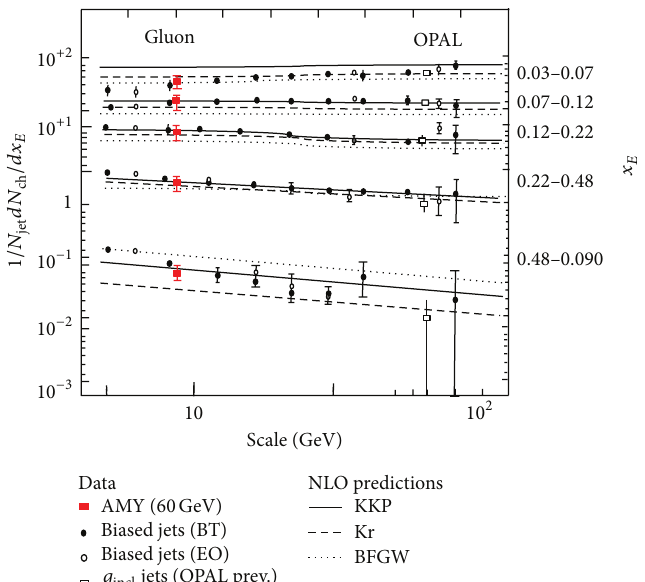
Figure 11: Scale dependence of the gluon fragmentation function in different 𝑥 𝐸 ’s intervals